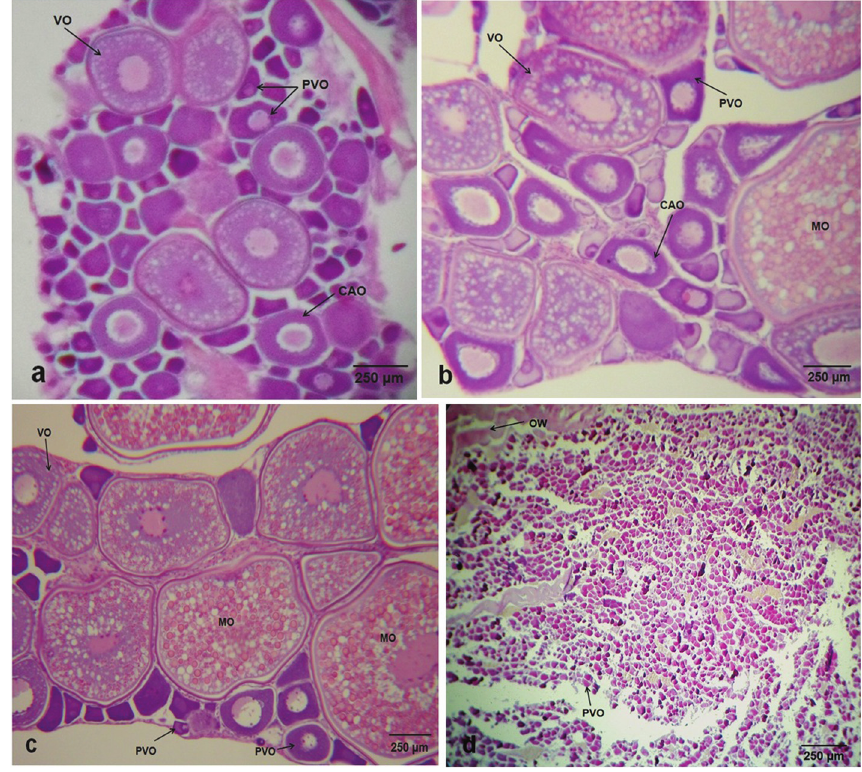
Fig. 6. Photomicrograph of ovaries sections of black triggerfish at different maturation stages. ( a ) early maturation, ( b ) middle maturation, ( c ) mature, and ( d ) resting. PVO: previtellogenic oocytes; CAO: cortical alveoli oocytes; VO: vitellogenic oocytes; MO: mature oocyte; and OW: ovary